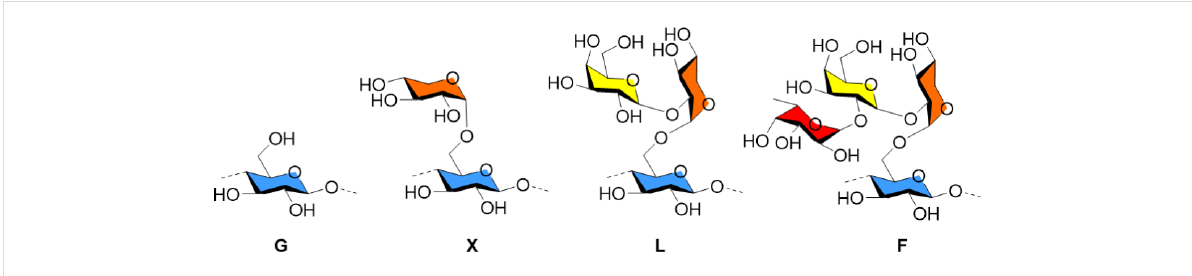
Figure 3: Chemical structure of the different branches G, X, L, F commonly found in XGs. Names are given following the established nomenclature [100].